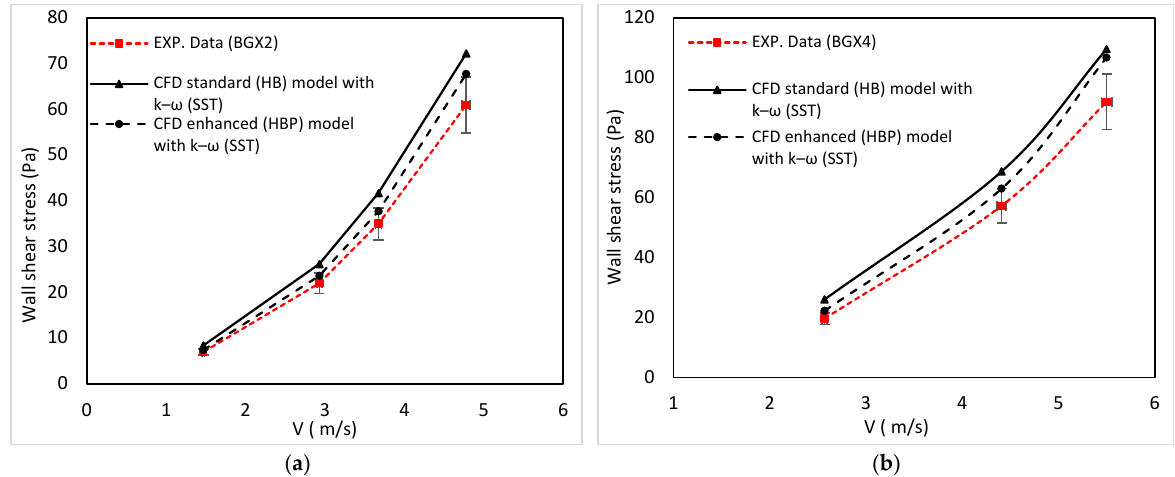
Figure 15. Comparison of pressure drop between experimental data and simulation results for standard and modi fi ed Herschel-Bulkley viscosity models: (a) BXG2 fl uid in pipe diameter 19.1 mm, (b) BXG4 fl uid in pipe diameter 76.2 mm.